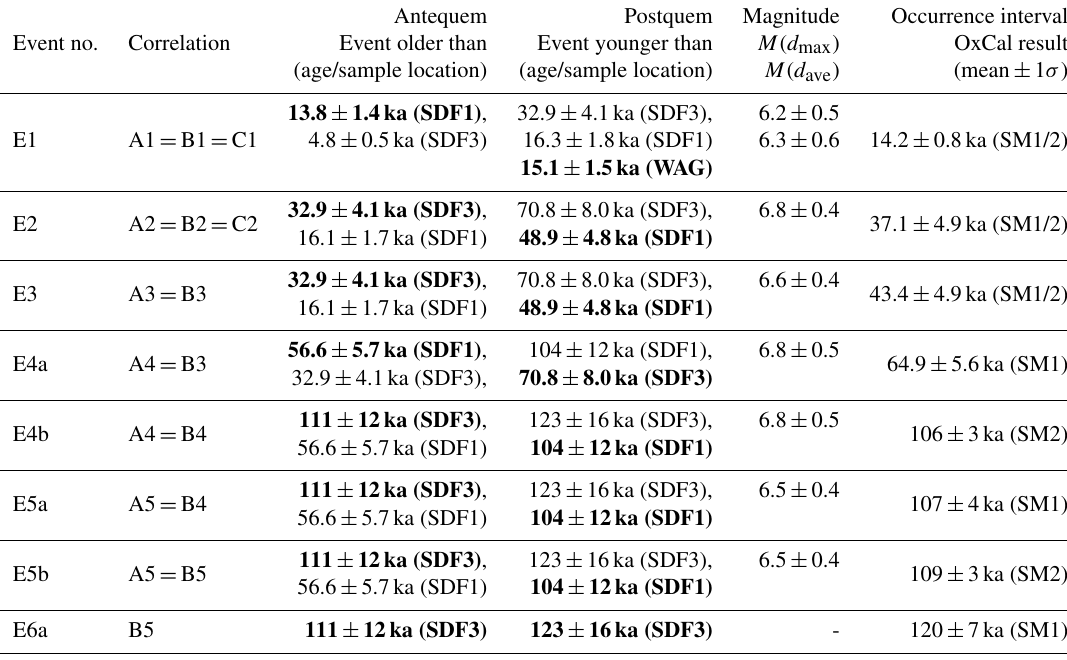
Table 3. Overview of characteristics of each possible earthquake derived from all sites.